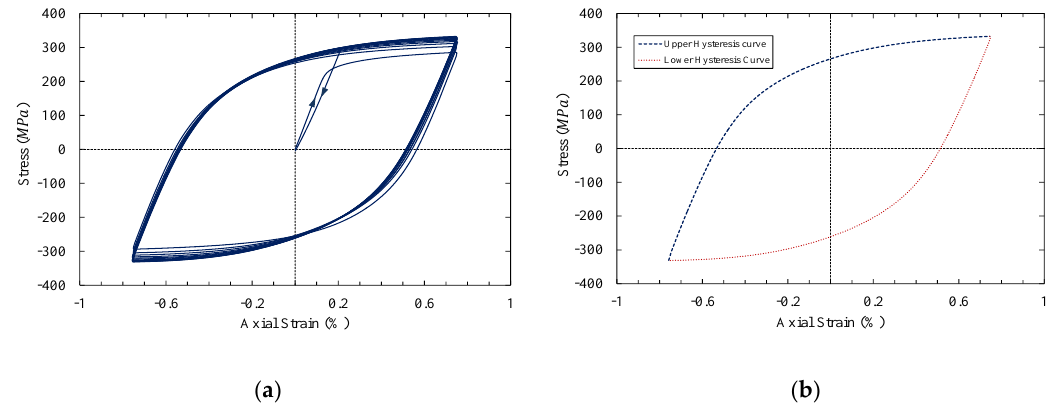
Figure 6. ( a ) Cyclic hardening behaviour of 316L stainless steel ( b ) stabilized hysteresis curve.